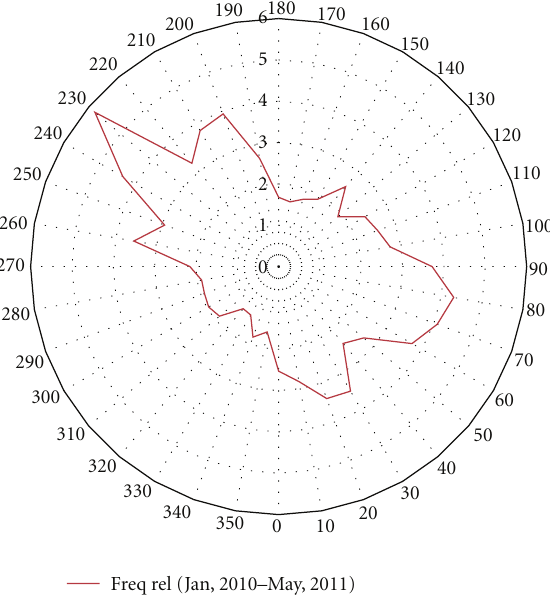
Figure 33: Relative frequency of occurrence of wave encounter angles.